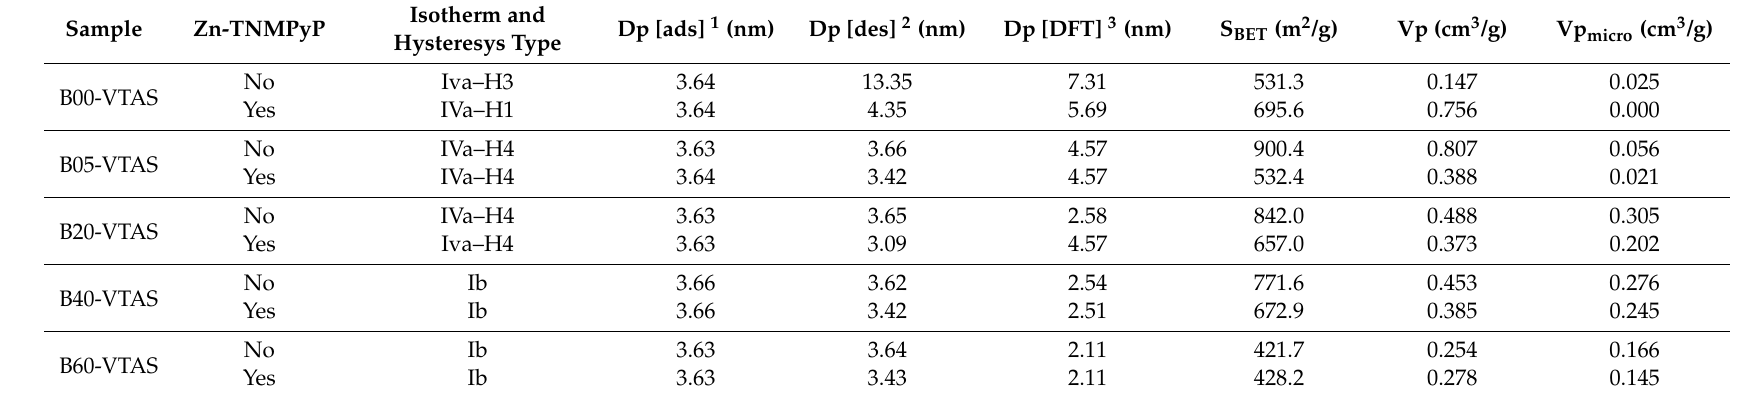
Table 2. Comparison of the textural properties of the silica gels with or without